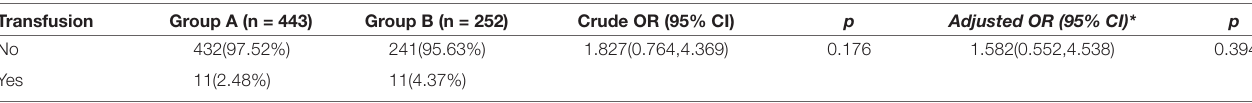
TABle 3 | Effect of Hemocoagulase Bothrops Atrox for inject on blood transfusion during operative.